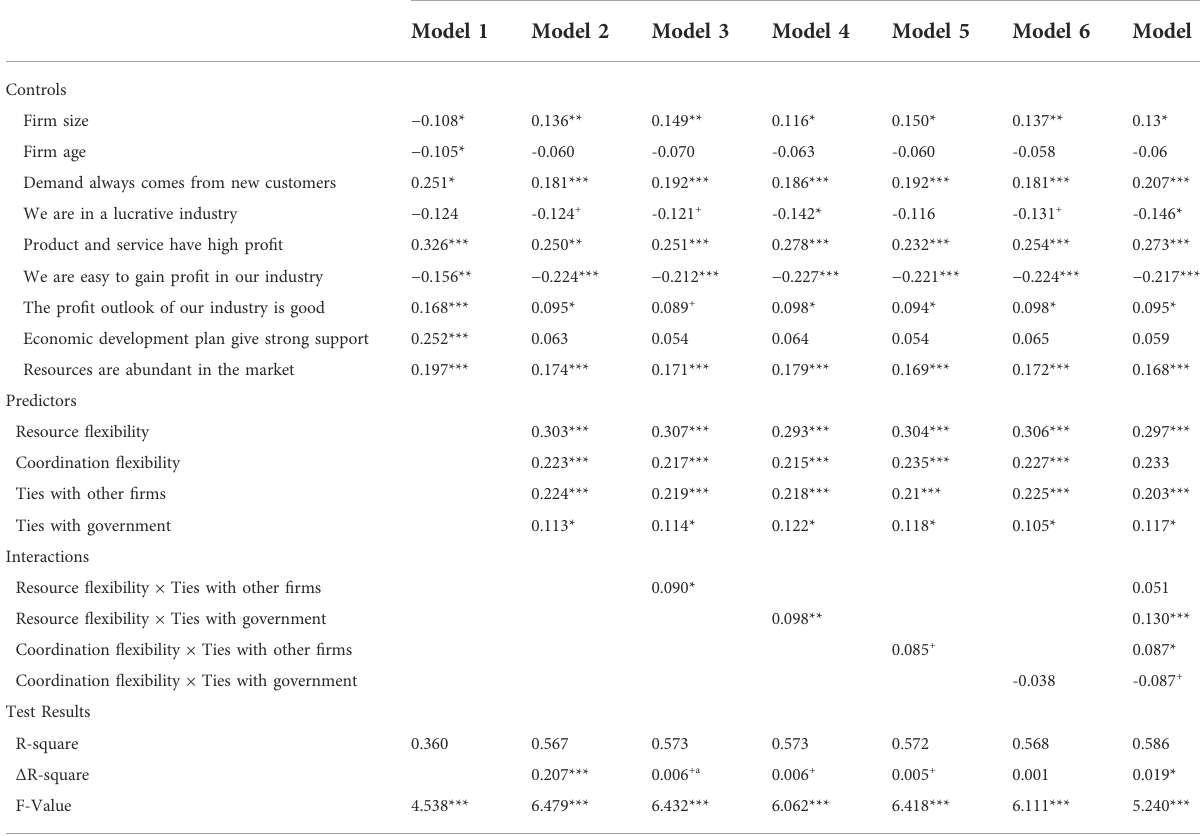
TABLE 3 Results of optimal scaling